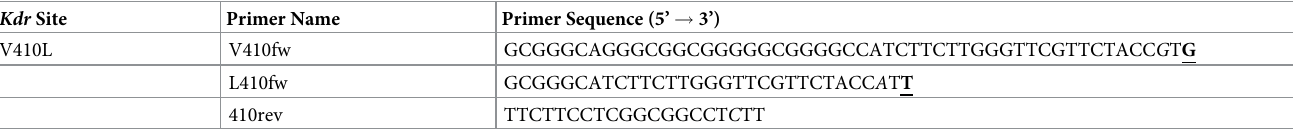
Table 1. Sequences of primers used for detection of the kdr V410L in the Aedes aegypti VGSC. Primers feature base pair mismatches introduced at the third base from 3’ end to increase allele specificity (italics); the diagnostic differential nucleotide is in bold, underlined [42]. Kdr